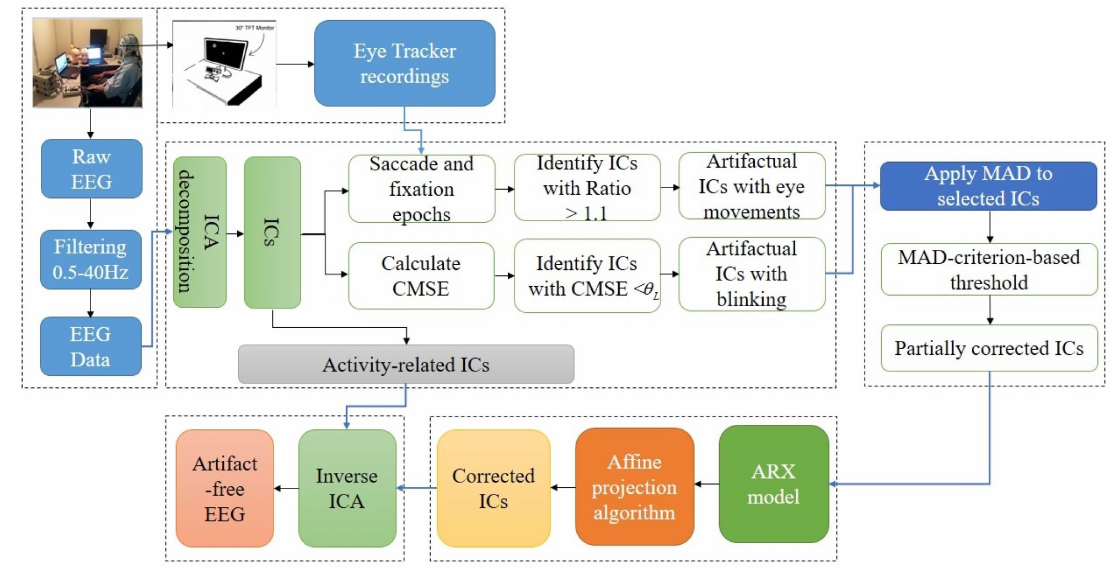
Figure 2. Schematic diagram of the proposed algorithm. Table 1. Summary of the proposed